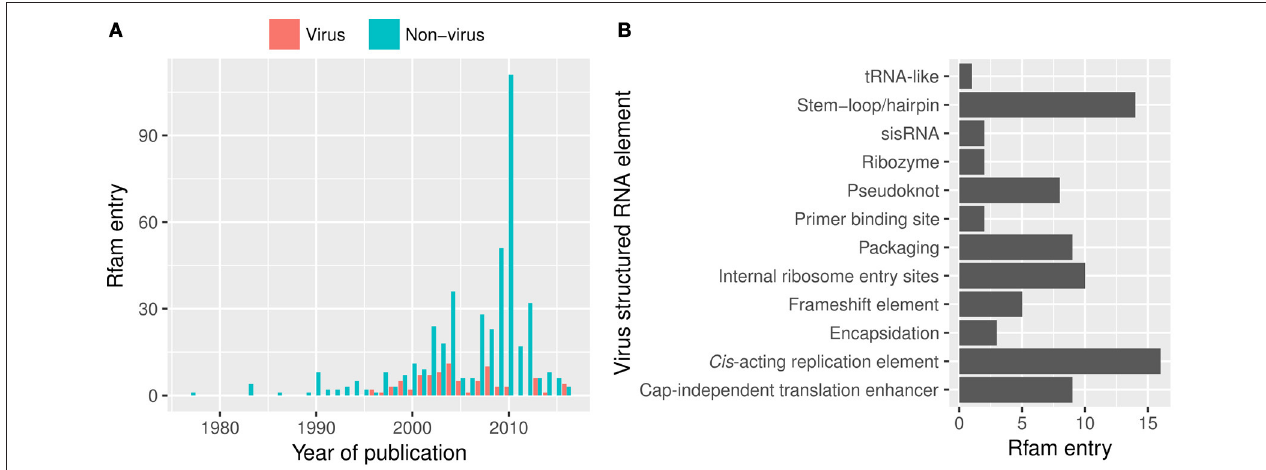
FIGURE 5 | Viral structured RNA elements from Rfam 12.2. (A) The number of the structured RNA families published in journal articles over the years and (B) viral RNA families available in Rfam. However, the viral entries are likely overrepresented by RNA structures at the untranslated regions as those located in the coding sequence are often overlooked. sisRNA, stable intronic sequence